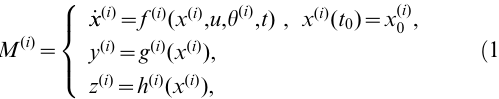
scaled to compensate for the fact that the data represent relative quantities only rather than absolute concentrations.